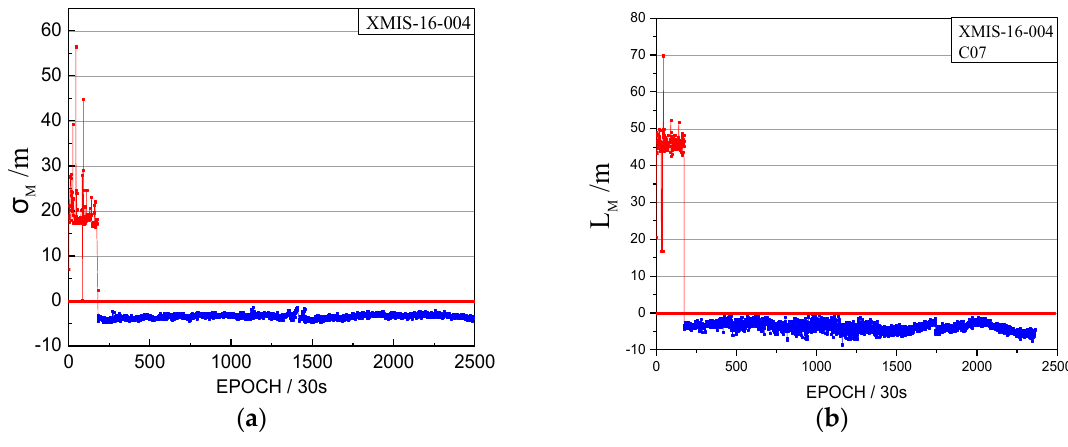
Figure 12. The abnormal time factor series and the satellite factor series. ( a ) The time factor series; ( b ) the satellite factor series.